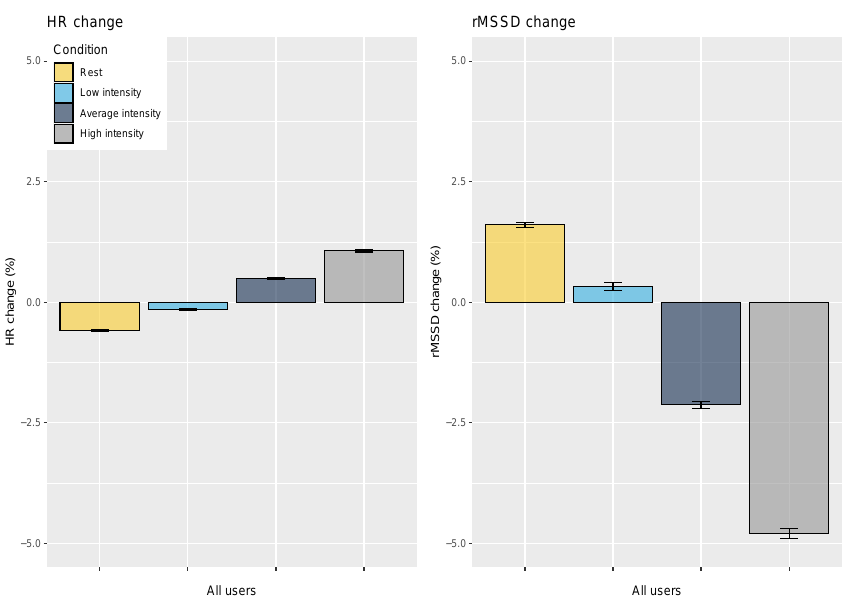
Figure 10. Relation between HR, HRV, and training intensity split into four categories. HR is consistently increased on days following higher training intensity, while rMSSD is consistently reduced. Relative changes in rMSSD are larger, highlighting how HRV can be more discriminative of training intensity. Error bars indicate the standard error.